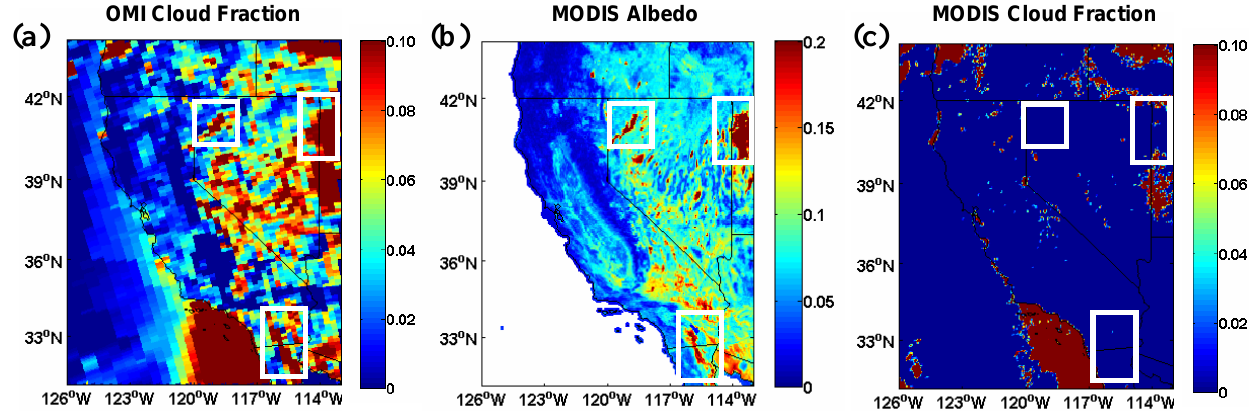
Fig. 3. Maps of California showing (a) OMI O 2 -O 2 derived cloud fractions, (b) MODIS MCD43C3 albedo, and (c) MODIS MYD06 cloud fraction for 18 June 2008. White boxes show regions where OMI and MODIS cloud fractions do not agree due to albedo effects.